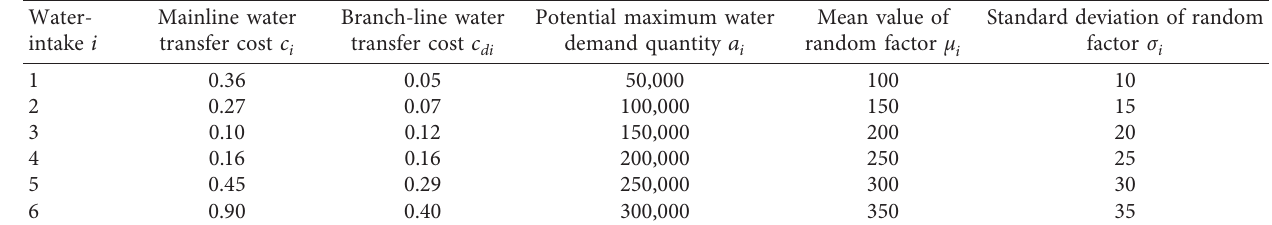
Table 5: List of parameters.